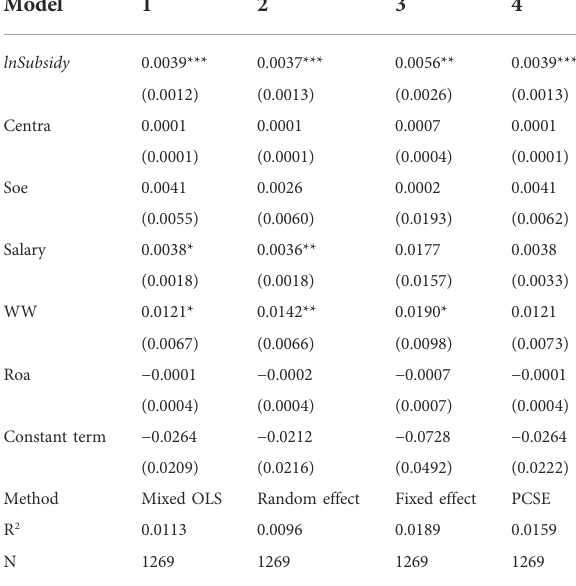
TABLE 4 Benchmark regression results.